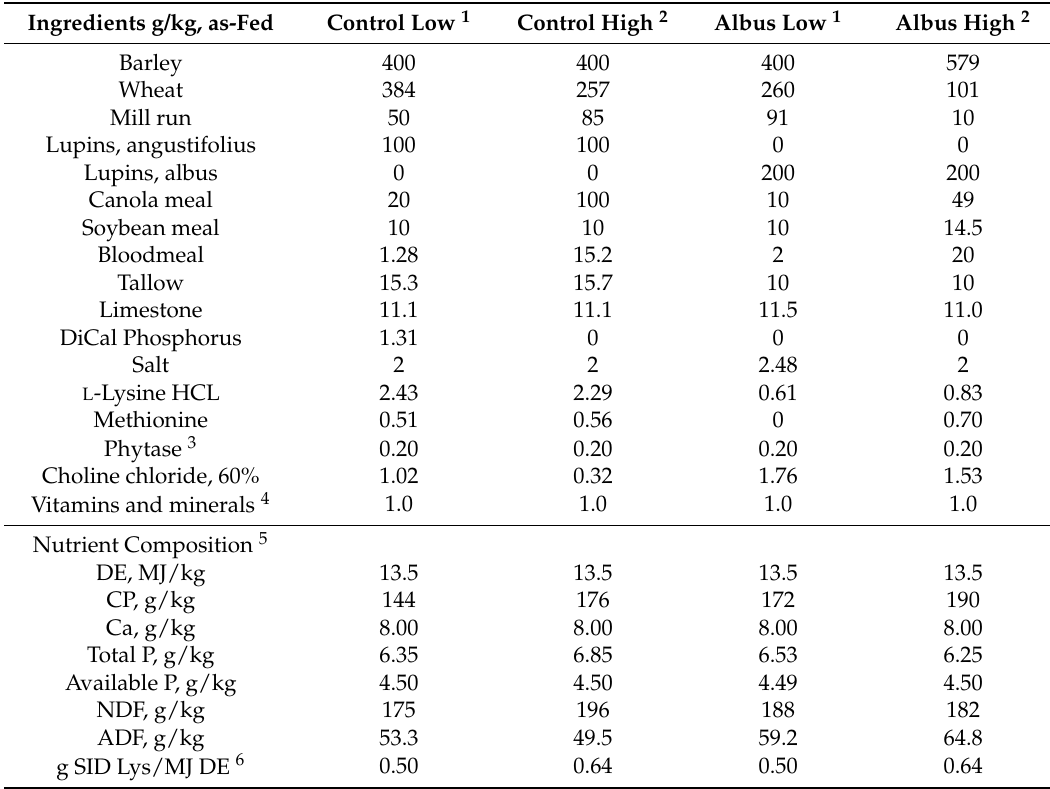
Table 1. Composition of the experimental